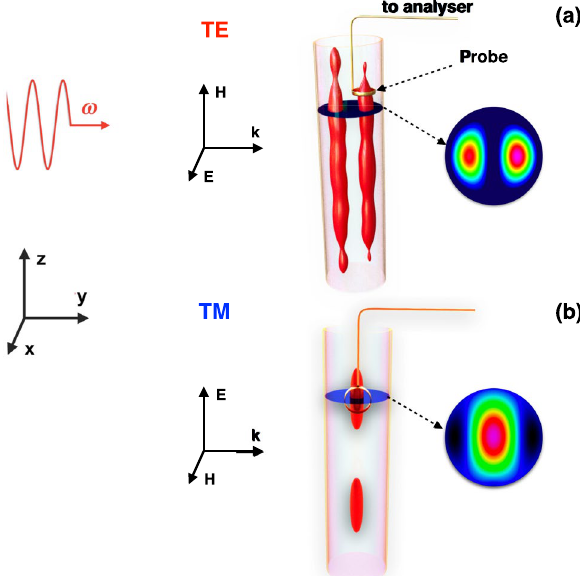
Figure 1. Schematic of the experiment. Linearly polarized plane electromagnetic wave with the circular frequency ω and vector k aligning parallel to the y -axis is scattered by a long hollow polystyrene cylinder, whose axis is parallel to the z -axis. The cylinder is filled with distilled water known to possess a high refractive index at the microwave frequencies. Magnetic field is measured by a probe placed inside the cylinder. The field profile and probe orientation are shown for two independent polarizations of the incident wave: ( a ) TE and ( b ) TM, respectively. The red balloons schematically represent surfaces of a constant value of | H | 2 . See the text for